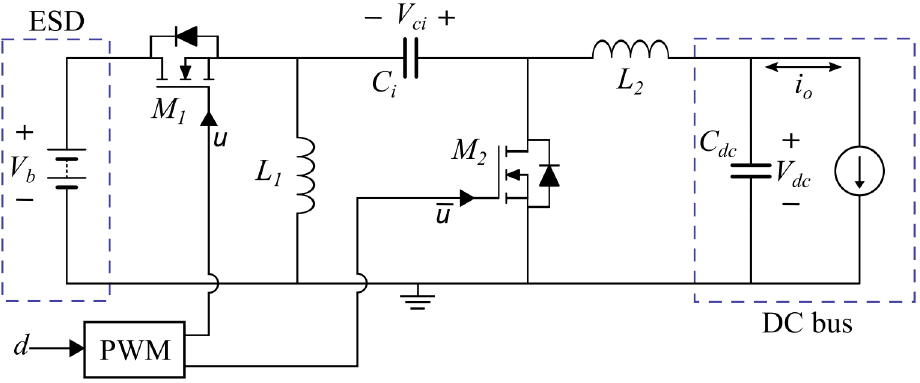
Figure 1. Sepic/Zeta-based circuital interface for bidirectional power flow.